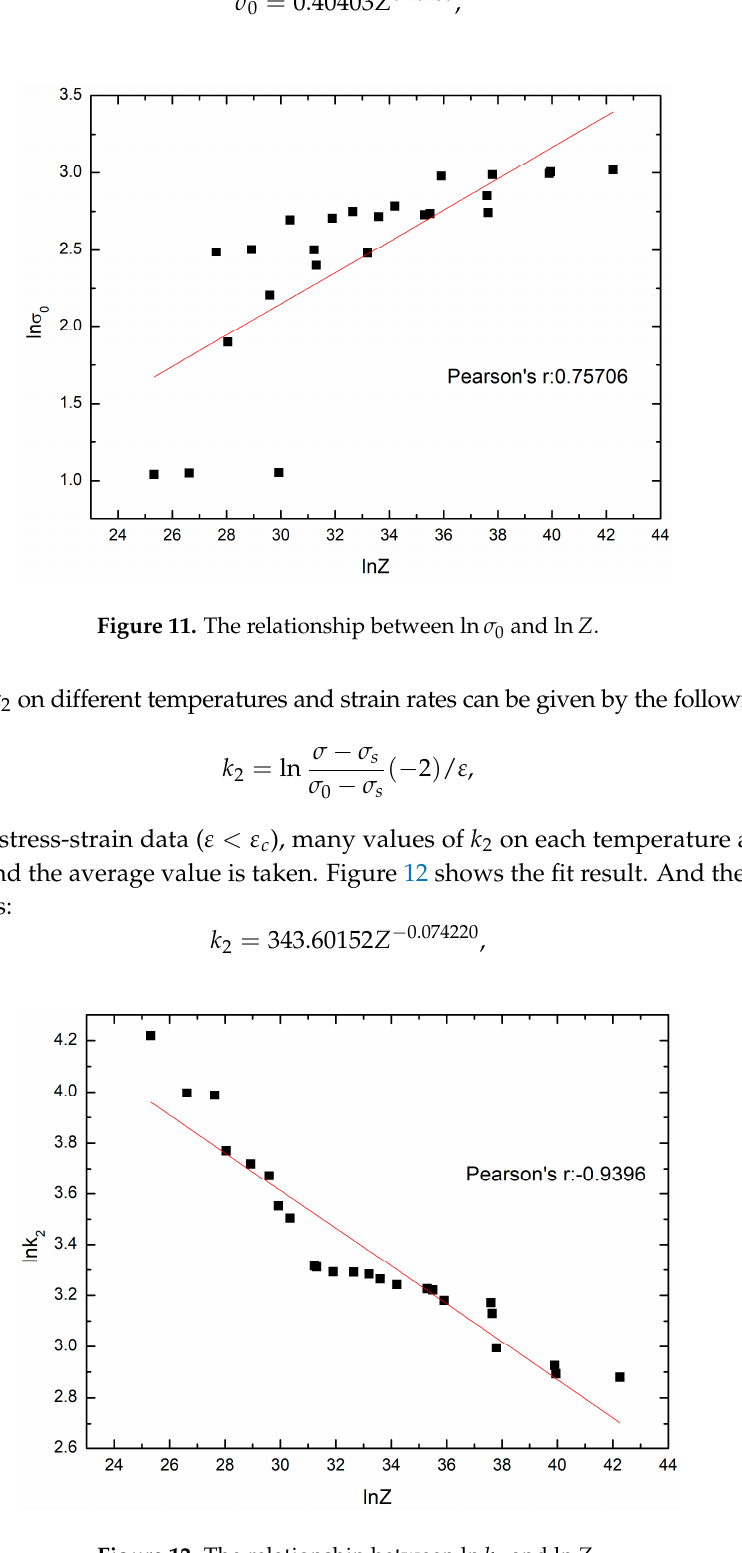
Figure 12. The relationship between ln k 2 and ln Z